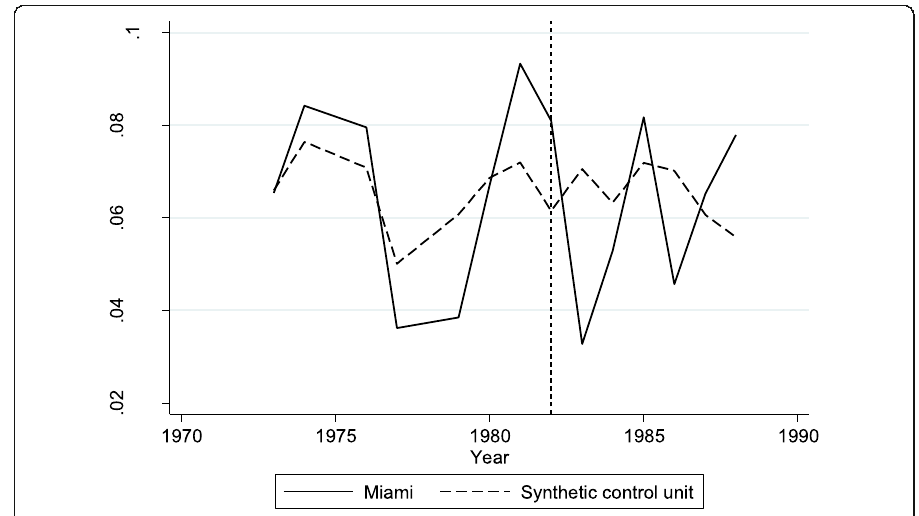
Fig. 1 Evolution of fertility rates for women age 15 – 44 (1973 – 1988): Miami vs synthetic control area. Year-specific fertility rates are constructed using data from the 1973 – 1988 Current Population Survey June Supplements. Computations for Miami are based on approximately 200 observations per year while computations for the synthetic control are based on approximately 4900 observations per